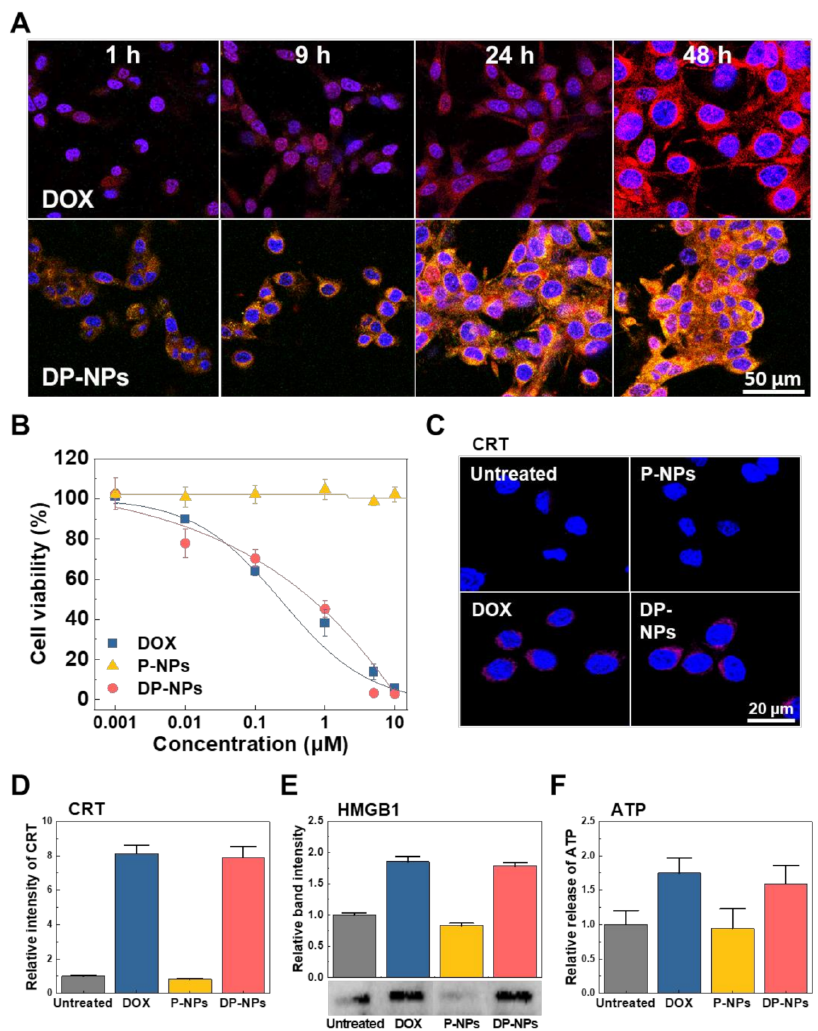
Figure 2. In vitro cellular uptake, cytotoxicity, and the subsequent ICD on the CT26 tumor cells. ( A ) Overlay confocal images of the time-dependent DOX-HCl and FITC-labeled-DP-NPs (2 µ M of DOX) uptake. Blue: DAPI; Red: DOX; Green: PLGA. The scale bar indicates 50 µ m. ( B ) Cell viability of DOX-HCl- and DP-NPs-treated CT26 tumor cells at increasing concentrations for 48 h using CCK-8. ( C ) Confocal images and ( D ) the quantified relative intensity of surface-exposed CRT in the DOX-HCl- and DP-NPs-treated (2 µ M of DOX) CT26 tumor cells for 48 h. The scale bar indicates 20 µ m. ( E ) Western blotting image and band intensity of released HMGB1 in the DOX-HCl- and DP-NPs-treated (2 µ M of DOX) CT26 tumor cell culture medium for 48 h. ( F ) ATP level in the DOX-HCl- and DP-NPs-treated (2 µ M of DOX) CT26 tumor cell culture medium for 48